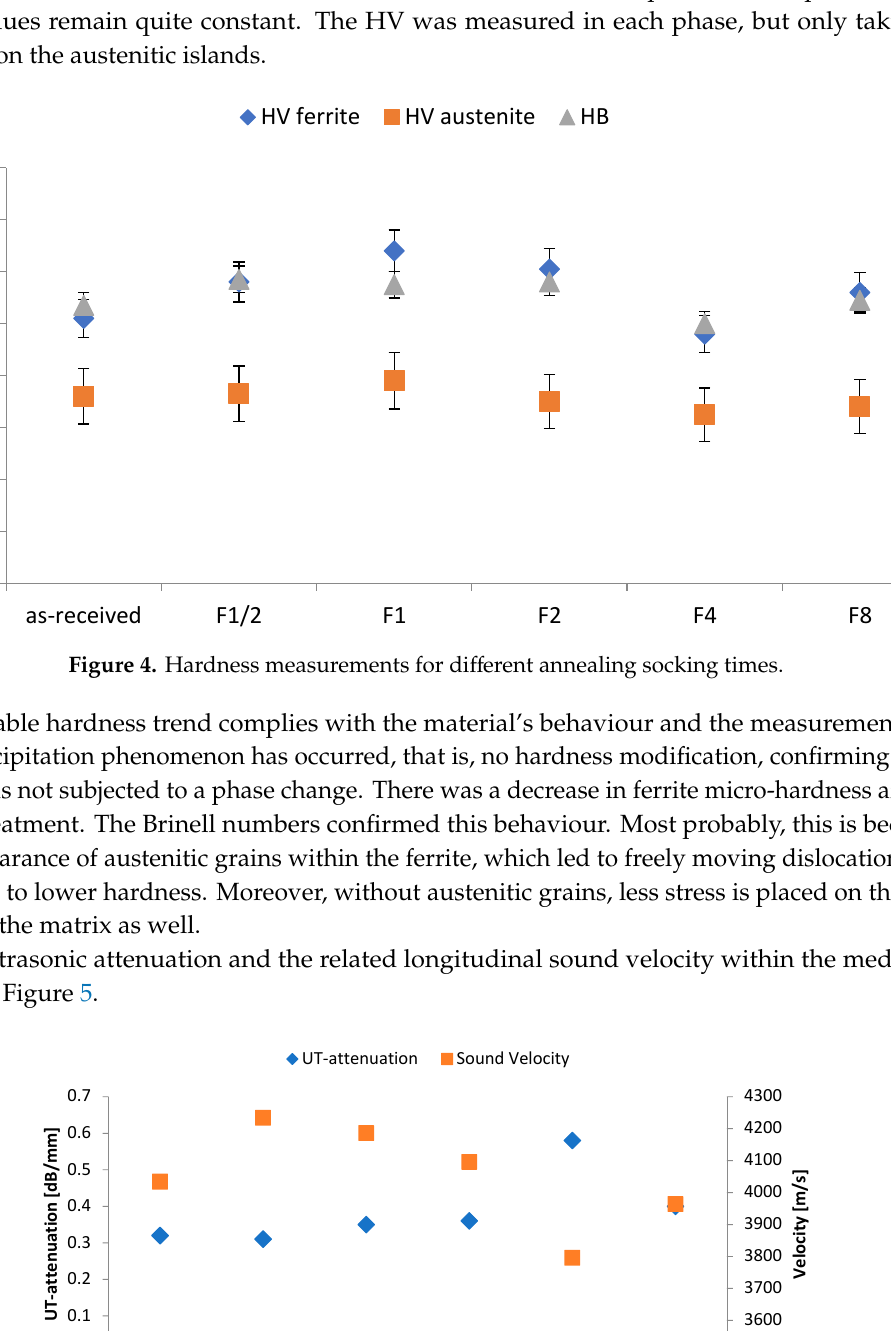
Figure 5. Ultrasonic test (UT)-attenuation results for different annealing socking times.